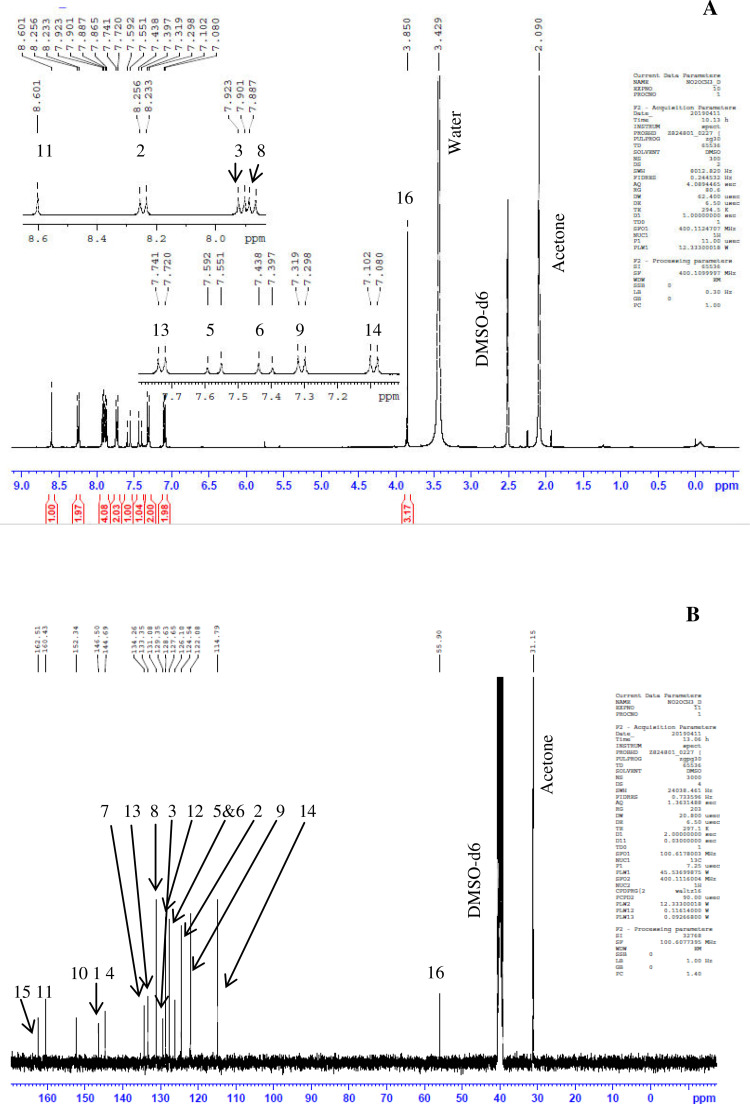
(A) 1H and (B) 13C NMR of NO2OMe.